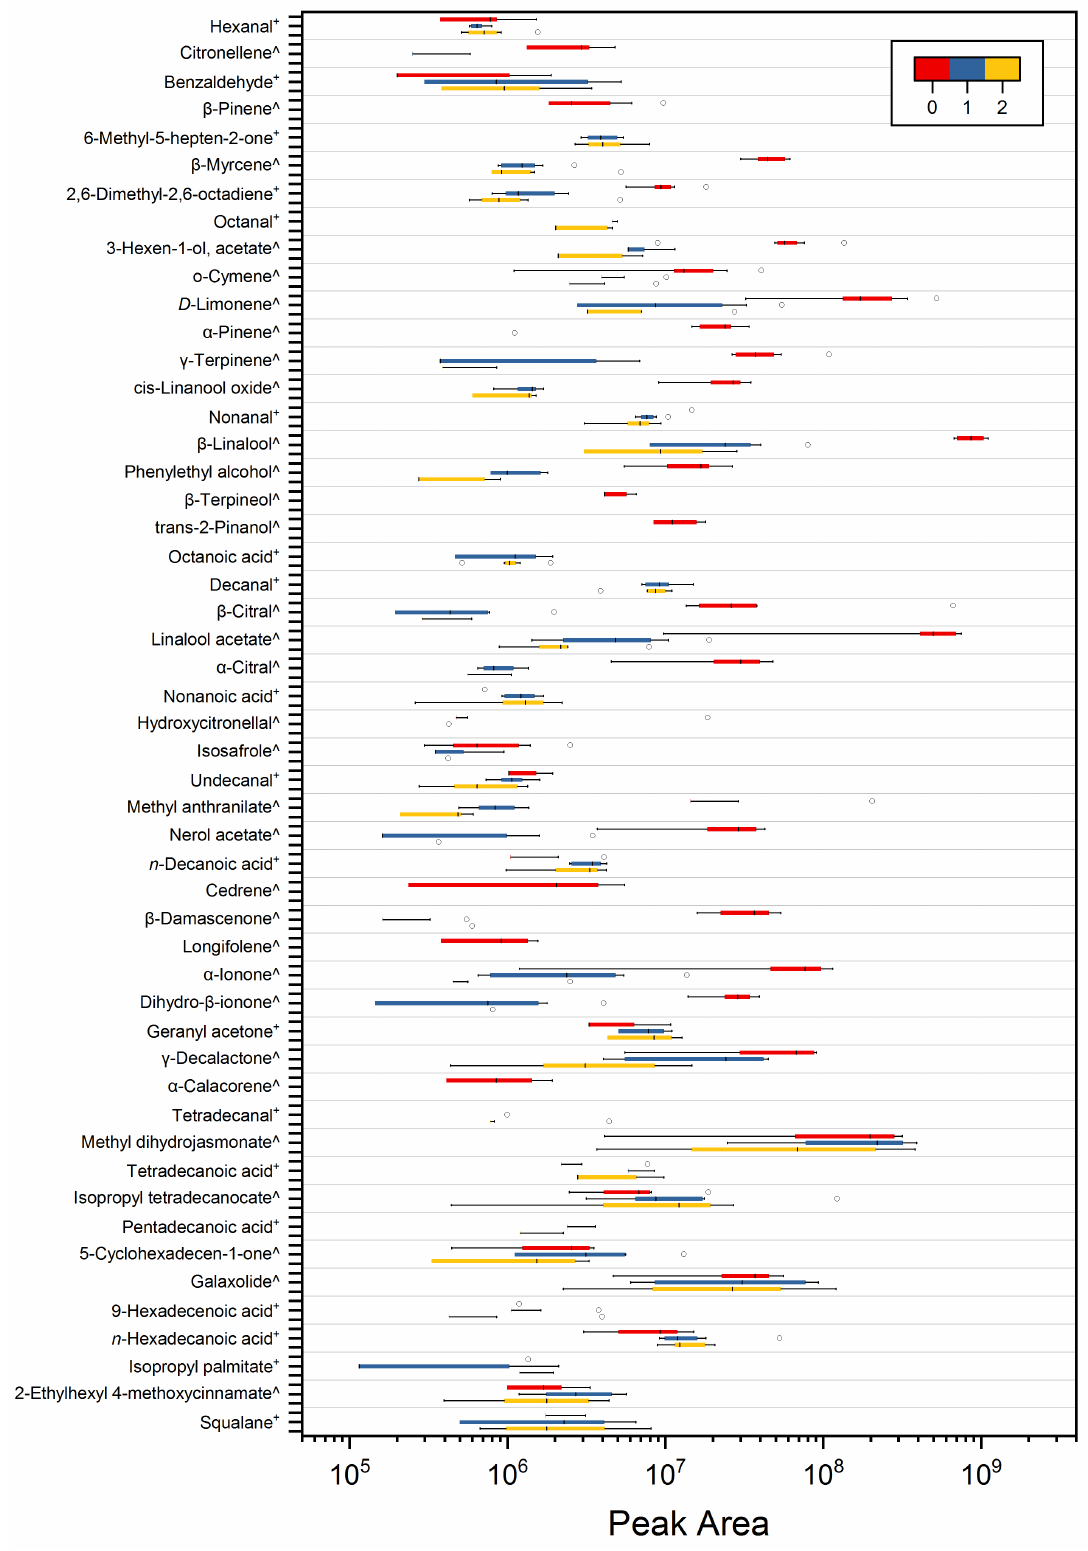
Figure 2. Box plot showing the inter-participant variance for fragrance-derived and endogenous volatiles recovered from participants’ skin headspace at 0 h (red), 1 h (blue), and 2 h (yellow). Box shows middle 50% of data with lines indicating the median. Whiskers represent range within 1.5 IQR. ( ◦ represents outliers; + indicates compound present in baseline skin volatile samples; ˆ indicates that the compound is